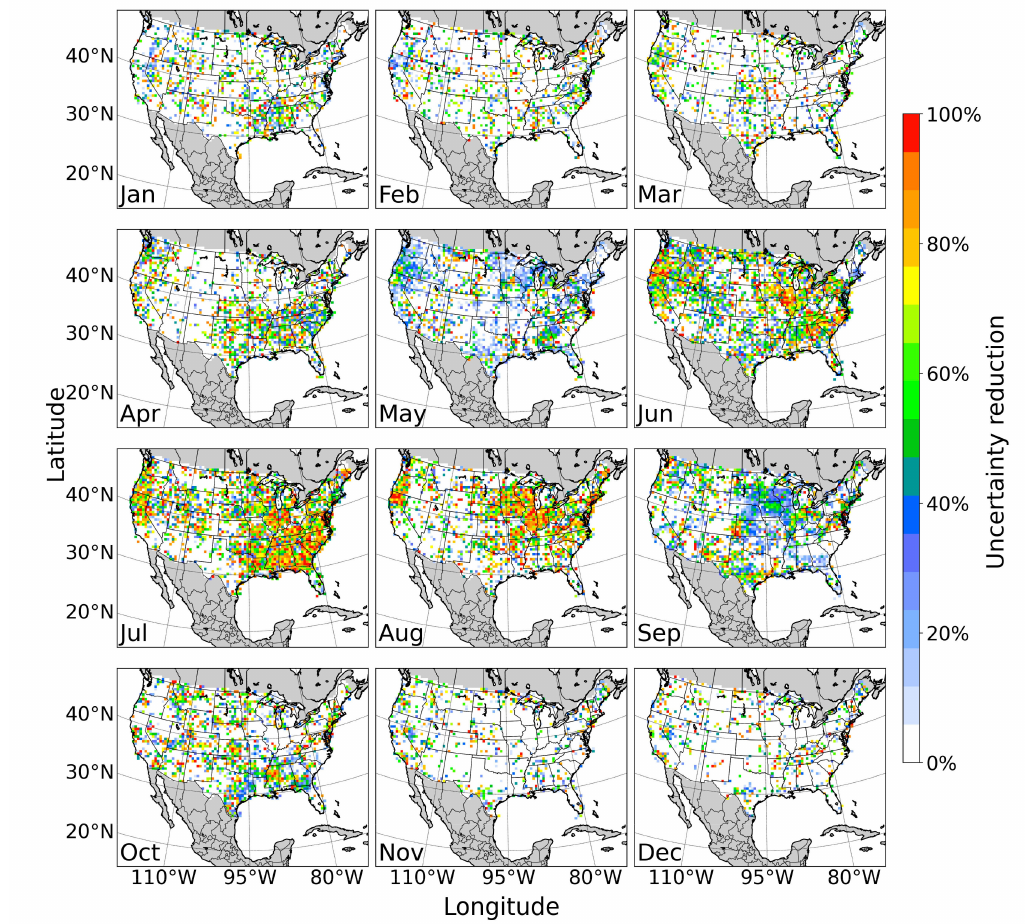
Figure 7. Spatial distribution of monthly mean uncertainty reduction between the posterior and the prior CO 2 flux in 2016 in the DA_FLUX